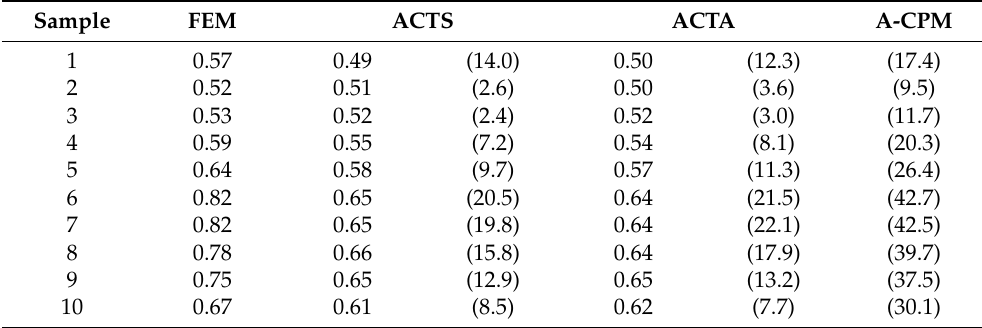
Figure 18. Comparison of the effective strain distributions in a randomly selected sample (#5) for ( a ) FEM, ( b ) ACTS, and ( c ) ACTA models. Table 3. The effective strain at the center of the FEM, ACTS, and ACTA models; the effective strain for the A-CPM model is uniform throughout each sample and the same for all samples, that is ε A-CPM = 0.47. The numbers in the parentheses are the calculated percentage